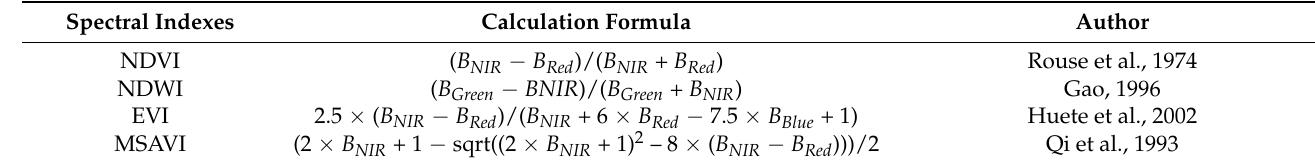
Table 2. The spectral indexes used in the study.